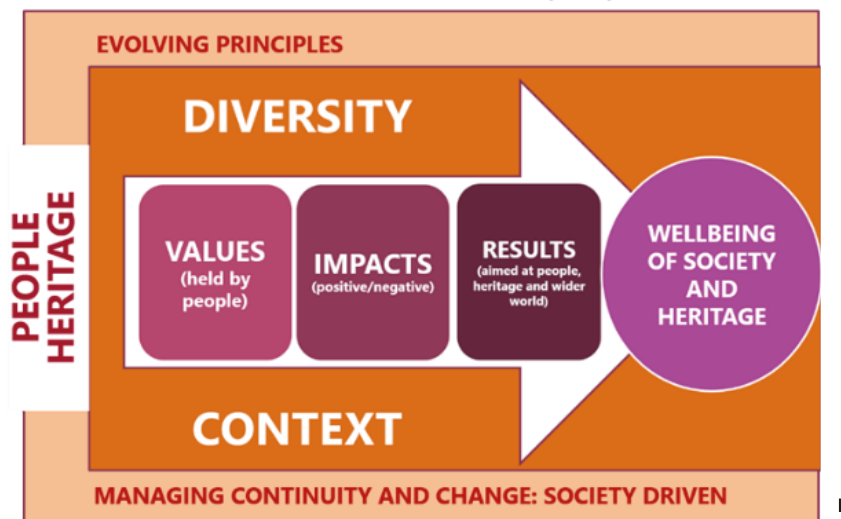
Figure 14 Approach to Management of Heritage (Source: Wijesuriya 2016b).